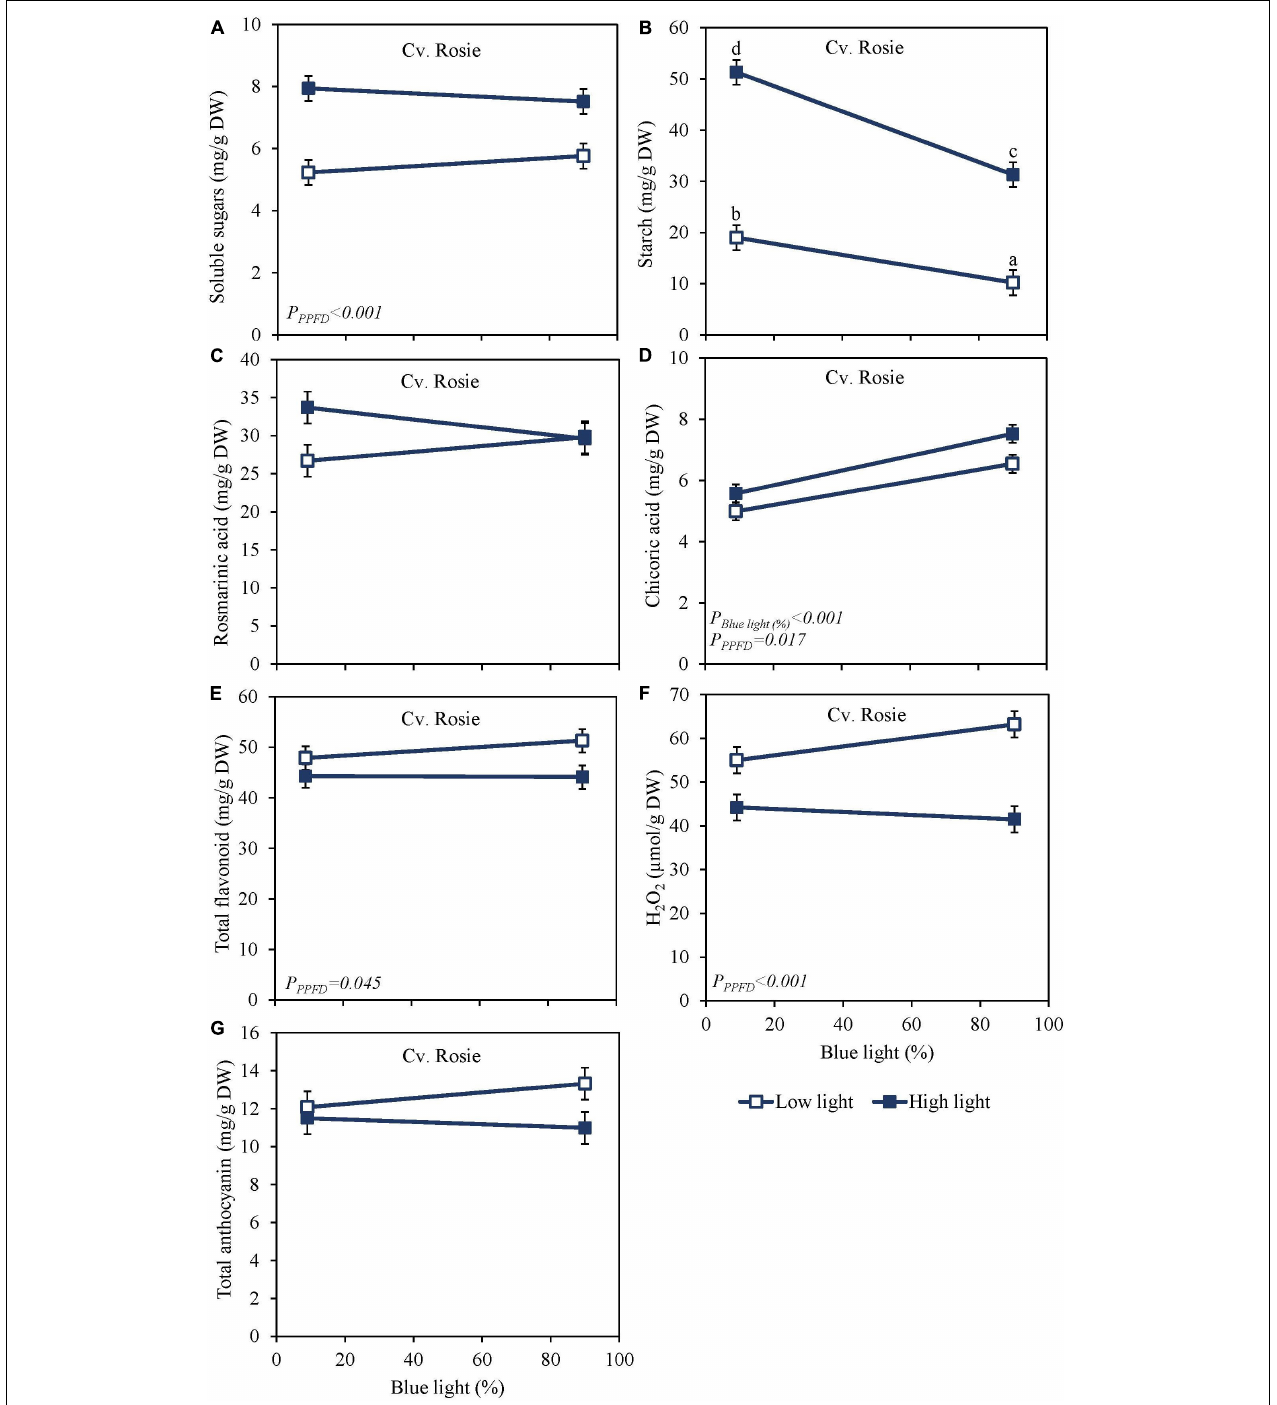
FIGURE 3 | Metabolite levels at harvest in basil the purple cv. Rosie were exposed to either 9% or 90% blue light at low PPFD (100 µ mol m − 2 s − 1 ) (open symbols) or high PPFD (300 µ mol m − 2 s − 1 ) (closed symbols) applied the last 5 days before harvest as EOP treatments. Before EOP treatments plants were grown under red-white light (PPFD of 200 µ mol m − 2 s − 1 , 9% blue) for 30 days. (A) Soluble sugars (sum of glucose, fructose, and sucrose), (B) starch, (C) rosmarinic acid, (D) chicoric acid, (E) total flavonoids, (F) H 2 O 2 , (G) total anthocyanins. All values are expressed per gram dry weight in the leaves. The data are means of four blocks ( n = 4) (i.e., per block four replicate plants). Standard errors of means are shown as error bars. Significance of the main effects percentage of blue light and PPFD ( α = 5%) are shown. Letters indicate and interactive effect between the two main effects (percentage of blue light and PPFD), (Experiment 2).